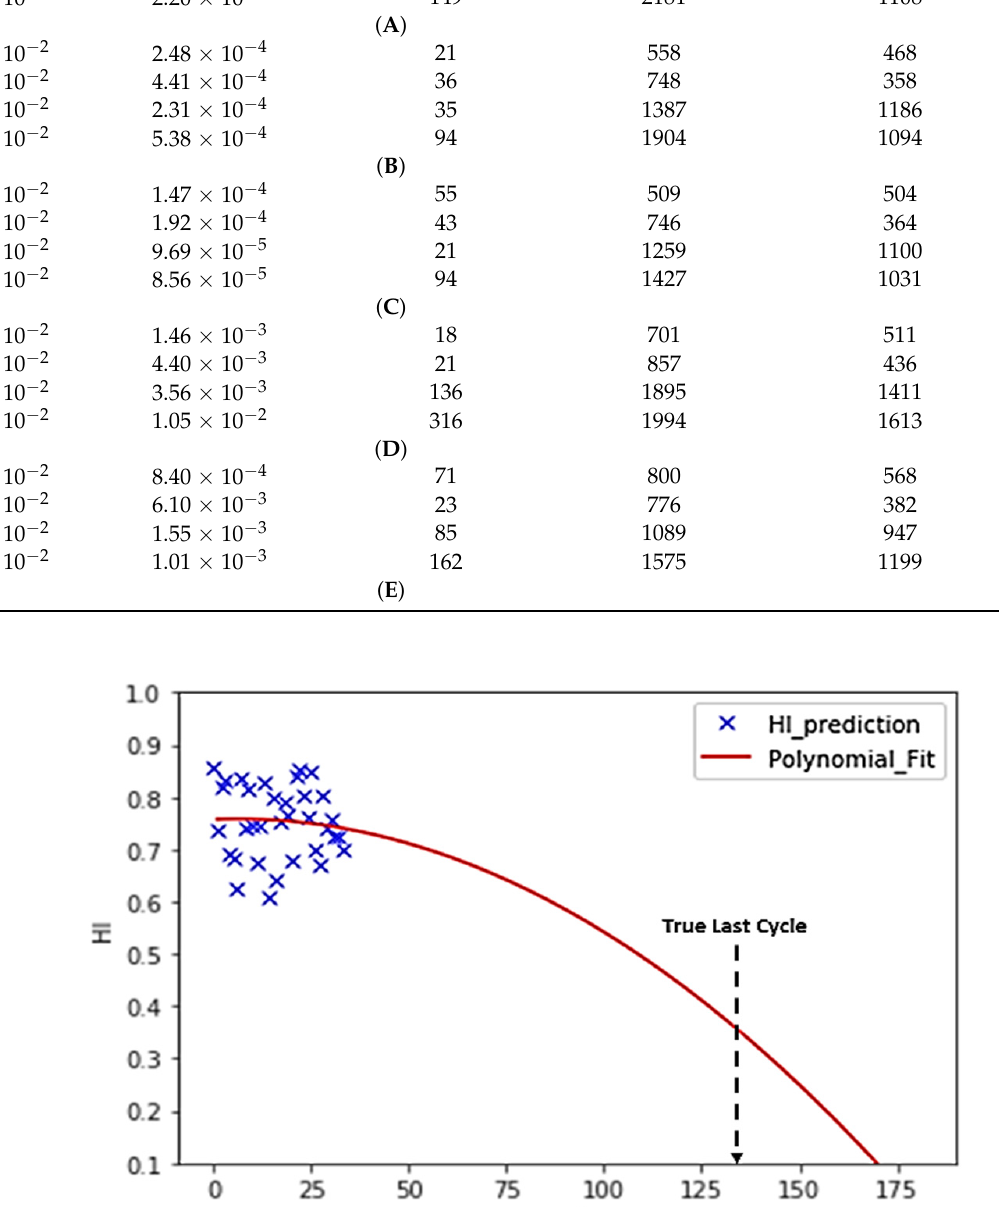
Figure 13. FD001_Test turbo unit 85 (34 cycles) test data validation.